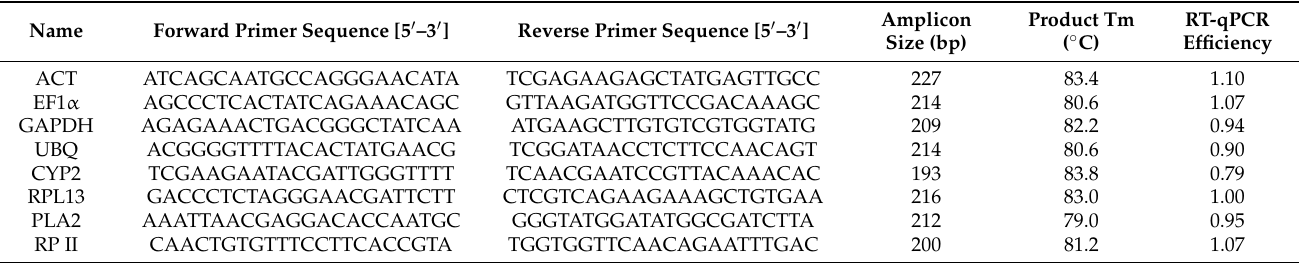
Table 2. Reference gene primer sequences and amplicon